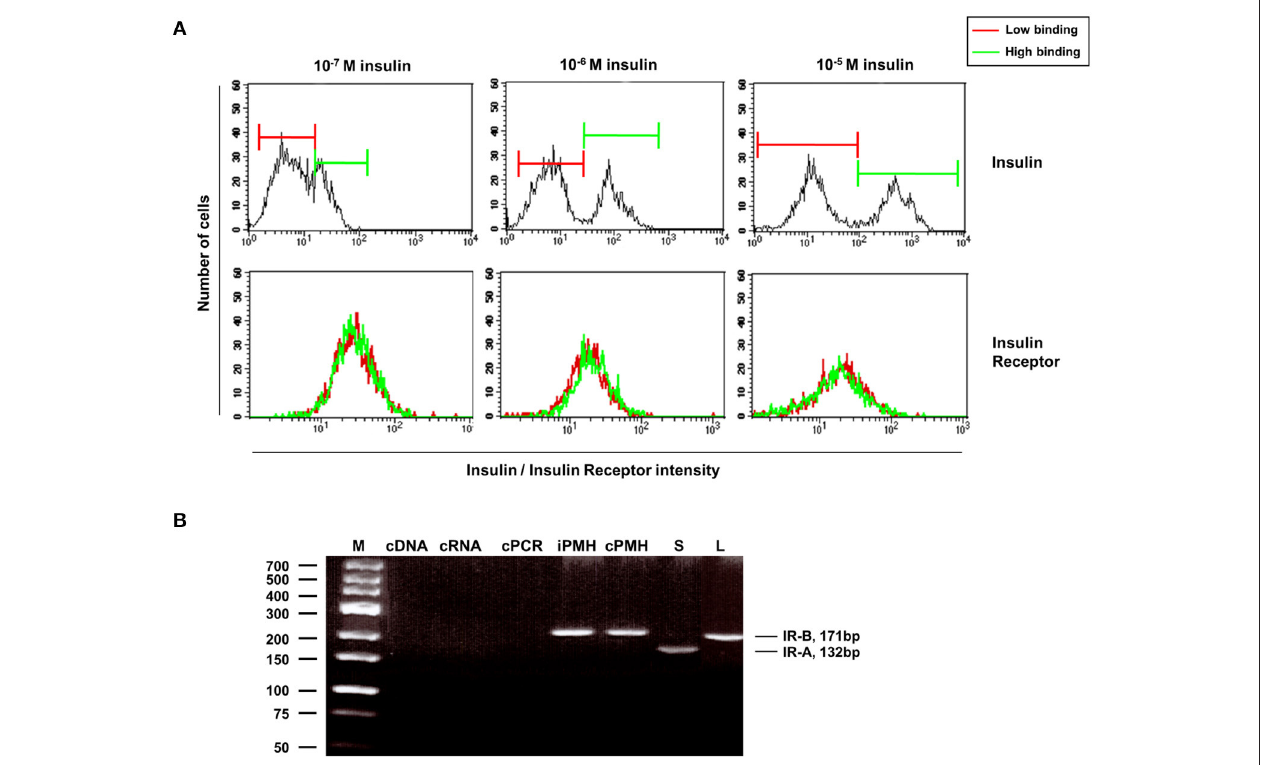
FIGURE 8 | Similar receptor expression found in hepatocytes with low and high insulin binding as seen by flow cytometry. (A) Upper panel: separation of insulin-low binding and insulin-high binding hepatocytes by different doses of insulin 5min after insulin incubation. Lower panel: similar IR expression in low and high insulin-binding hepatocytes after their separation according to their insulin affinity. (B) Expression of insulin receptor variants in primary cells as determined by RT-PCR using the fact that the variant B expresses an additional exon. GeneRuler Low Range DNA Ladder (Fermentas, Thermo Fisher Scientific, Darmstadt, Germany) was used as Marker (M). Controls were the following: PCR using water for the cDNA synthesis instead of RNA (cDNA); PCR using RNA as template instead the synthesed cDNA (cRNA); PCR using water in the PCR reaction instead cDNA (cPCR). iPMH, fresh isolated hepatocytes; cPMH, hepatocytes after overnight cultivation; S, spleen; L, murine